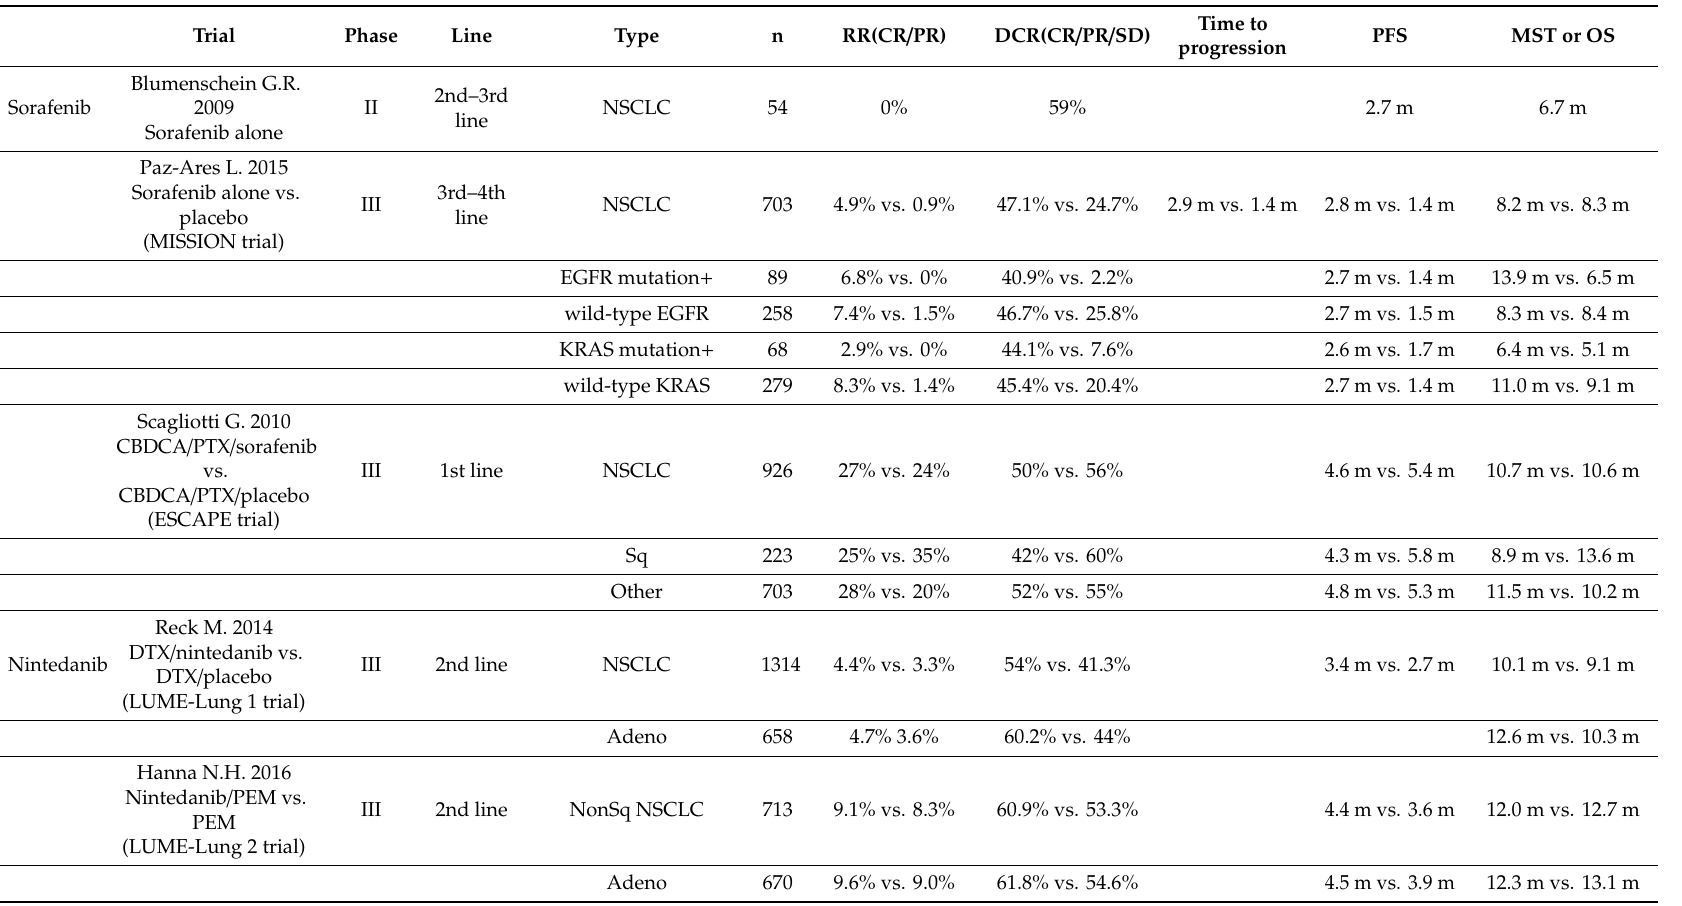
Table 3. Results of clinical trials of sorafenib and